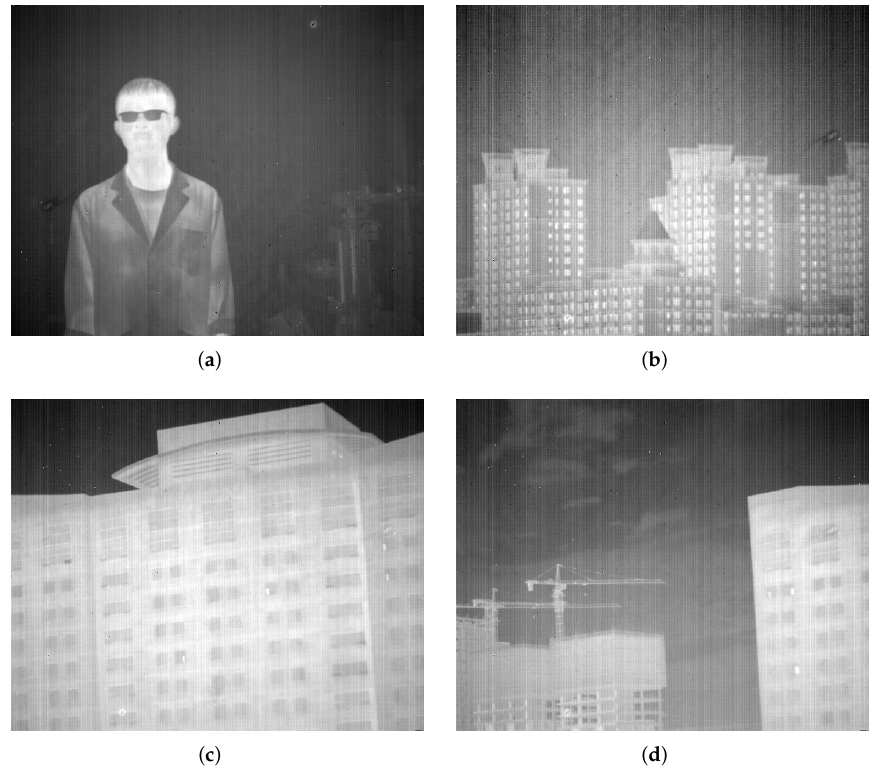
Figure 6. Experimental images : (a) a person; (b) buildings against the sky; (c) a single building; (d) complex buildings.